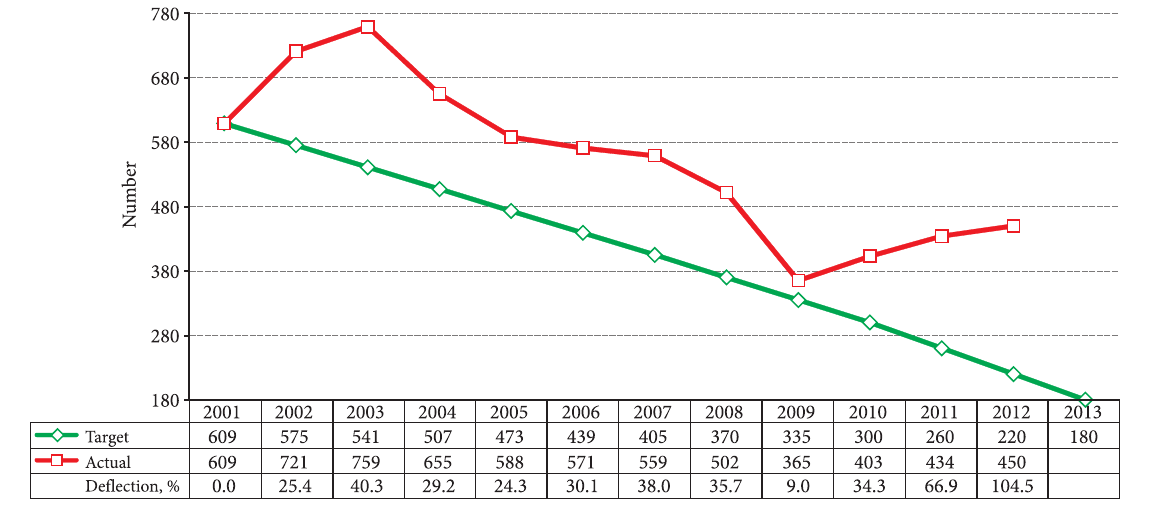
Fig. 11. Number of children killed and injured in road traffic accidents and the target for 2001–2012